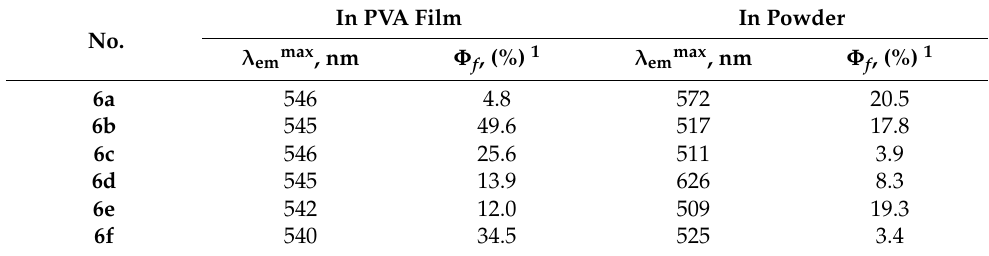
Table 4. Optical properties of the compounds 6a – f in the solid state and in PVA film.